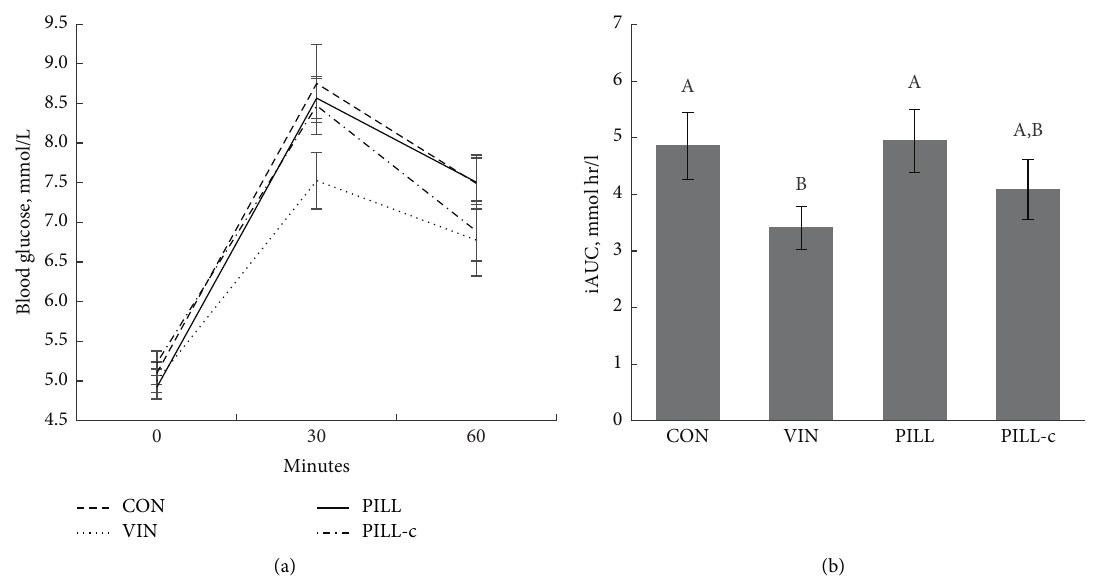
Figure 1: (a) Line graph representing the 60-minute postprandial flux in blood glucose under four test conditions: CON, 60g water (control treatment); VIN, 25g liquid vinegar (1.25g acetic acid) diluted with 35g water; PILL, four vinegar tablets (1.50g acetic acid) swallowed whole with 60 g water; and PILL-c, four crushed vinegar tablets dissolved in 60g water ( p � 0.089; repeated measures ANOVA). (b) The blood glucose incremental area-under-the-curve (iAUC) for the four test conditions ( p � 0.043; repeated measures ANOVA). Columns that do not share a common superscript differ significantly ( p <